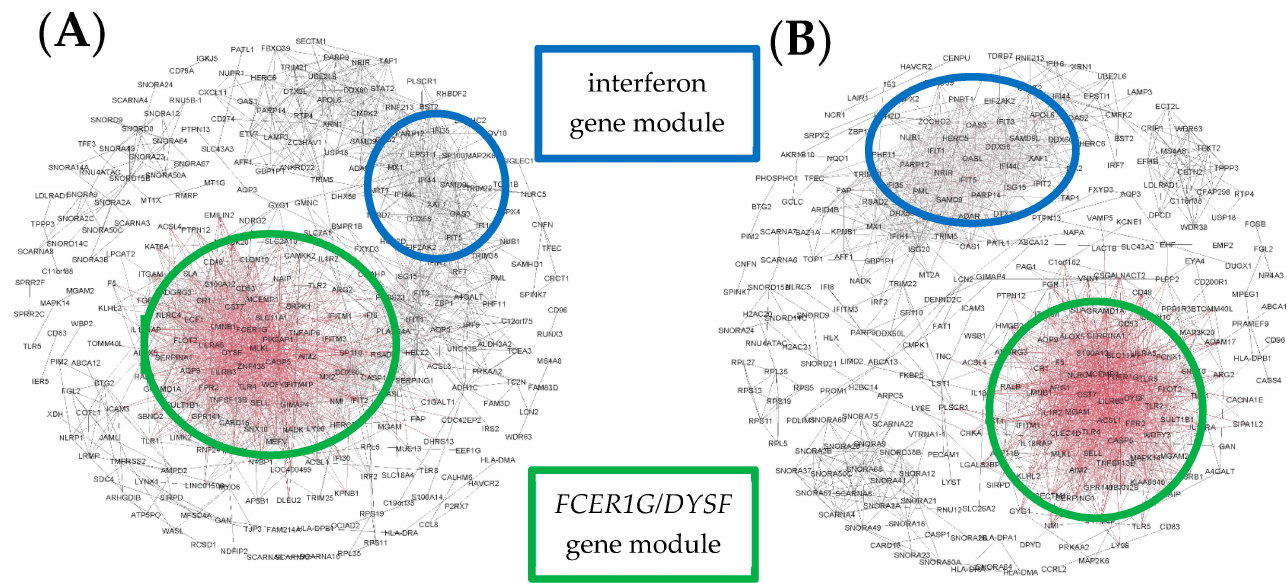
Figure 6. Illustrative examples of personal gene network structures generated in Gephi for representative subjects from Cluster C. Example ( A ) shows a network where the modules overlap, whereas in Example ( B ) the modules are isolated. Red indicates highly connected genes (“hubs”) and black denotes genes with few connections.